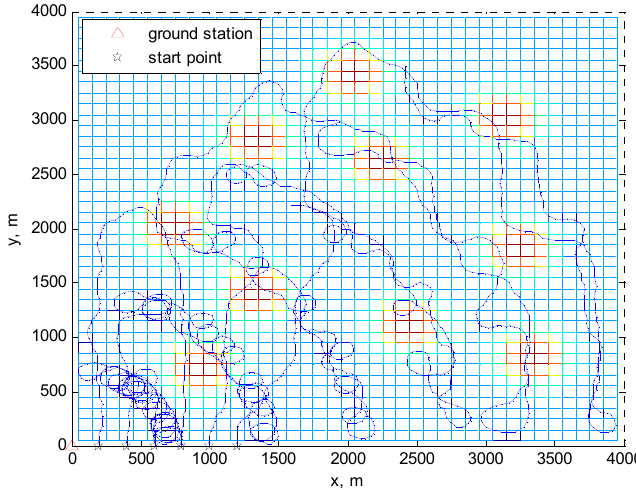
Figure 5. UAVs cooperative surveillance trajectories.